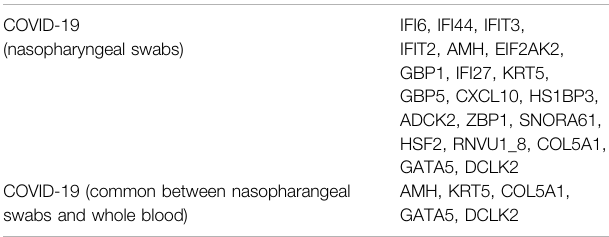
TABLE 8 | List of genes that are differentially expressed in COVID-19 analyzed from GSE163151. COVID-19 (nasopharyngeal swabs)